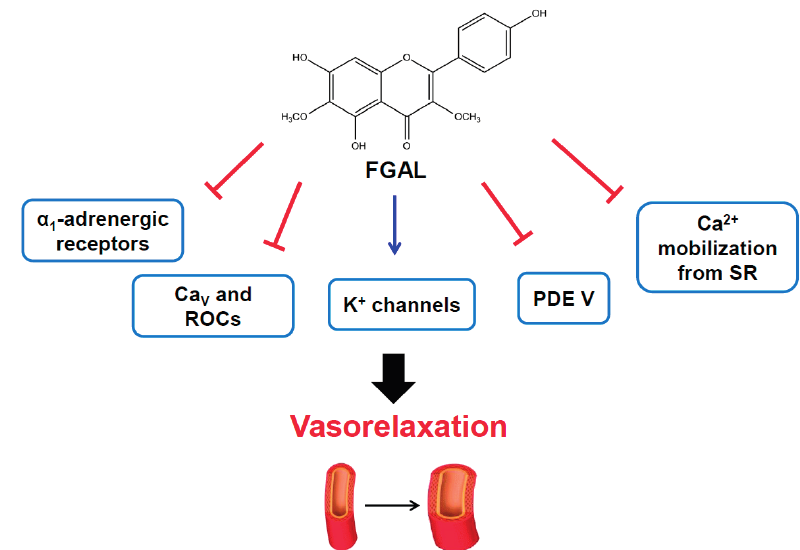
Figure 10. Overall study scheme representing the effect of FGAL on inducing rat aorta